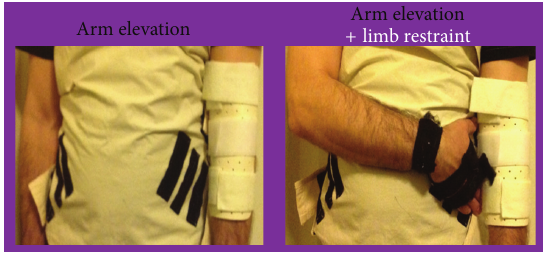
Figure 2: An illustration of the setup used to ensure restraint and specific mobilization of the shoulder